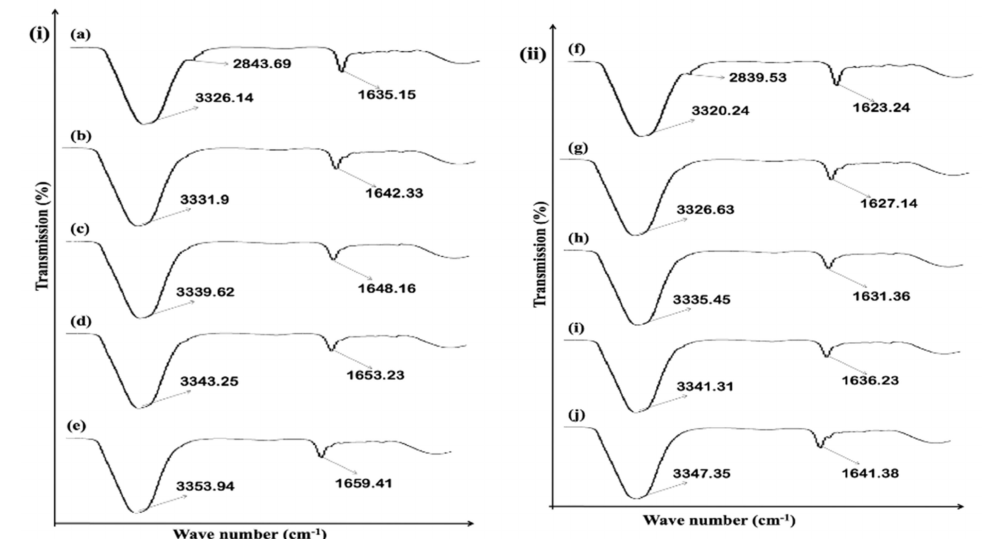
Figure 11. ( i ): Representation of rabbit skin epidermis FTIR: ( a ) untreated ( b ) treated with F5 (Control), ( c ) treated with F5-EO-5%, ( d ) treated with F5-NMP-5%, and (e) treated with F5-OA-10%; ( ii ): representation of rabbit skin dermis FTIR: ( f ) untreated, ( g ) treated with F5 (Control), ( h ) treated with F5-EO-5%, ( i ) treated with F5-NMP-5%, and ( j ) treated with F5-OA-10%. Data are expressed as mean ± SD, n =